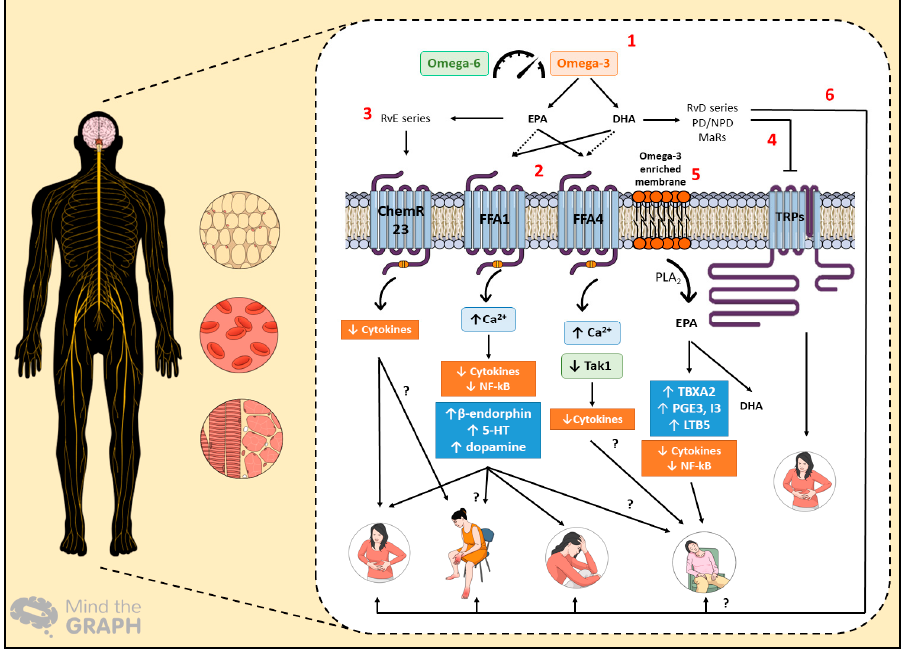
Figure 2. The proposed mechanisms of action for omega-3 polyunsaturated fatty acid (PUFA) intake in cancer-related complications, which affect the central and peripheral nervous system, besides adipose tissue and skeletal muscle. Hematological changes depict the switched production of systemic inflammatory mediators under cancer progression. (1) The balance between omega-3 and omega-6 PUFAs is essential for the generation of pro-resolution mediators, the sensing of free fatty acid receptors, and membrane modulation. (2) Eicosapentaenoic acid (EPA) and docosahexaenoic acid (DHA) can stimulate Free Fatty Acid Receptor 1 (FFA1) and Free Fatty Acid Receptor 4 (FFA4) receptors in different ways, leading to anti-inflammatory effects. FFA1 activation can evoke analgesia and antidepressant effects. Additionally, this receptor could have benefits in relation to paraneoplastic syndromes, such as neuropathy and cachexia-anorexia syndrome, represented herein by fatigue. (3) E-series resolvins (RvE) promotes anti-inflammatory effects via ChemR23 activation, likely contributing to the alleviation of painful symptoms. They might also induce beneficial effects in other paraneoplastic syndromes. (4) The inhibitory effects of D-series resolvins (RvD) on transient receptor (TRP) channels could also produce favorable effects on cancer-related pain. (5) As for the omega-3 PUFA membrane enrichment, the production of thromboxane A2 (TBXA2), prostaglandins E3 and I3 (PGE3/I3), and leukotriene B5 (LTB5) promotes anti-inflammatory effects that prompt cachectic patients’ welfare. (6) Finally, RvD-series, protectins/neuroprotectins (PD/NPD), and maresins (MaRs) have beneficial effects on pain and depression; thus, they could similarly relieve the signs and symptoms of paraneoplastic and cachexia-anorexia syndromes.